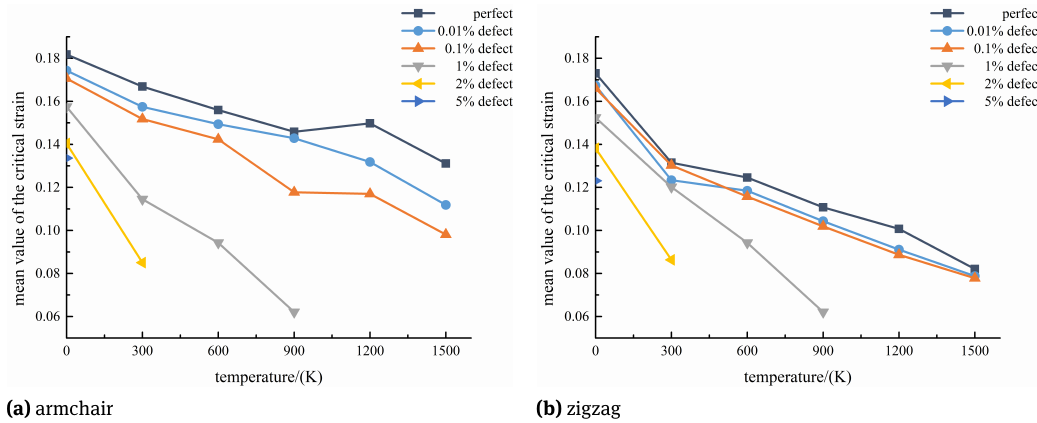
Figure 9: Mean fracture strain as a function of temperature with different percentage of vacancy defect.